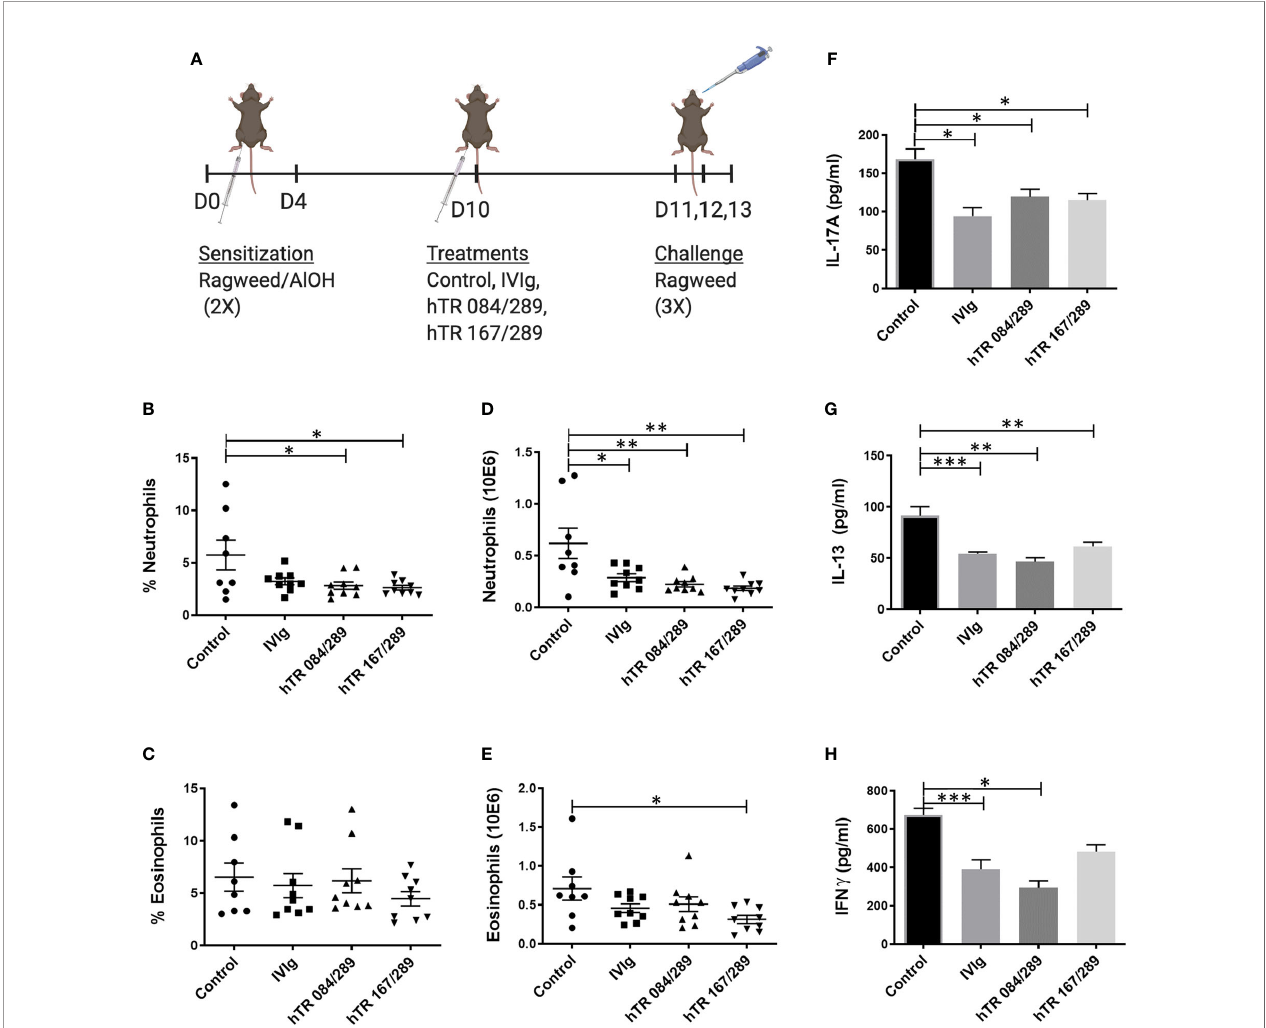
FIGURE 3 | Tregitopes modulate lung granulocytes and cytokines pro fi le of mice with ragweed-driven murine allergic airways disease. In the more acute ragweed model of allergic airway diseases, Tregitopes (and IVIG) signi fi cantly reduce cellular in fi ltration (neutrophil as well as eosinophils) and broadly reduce cytokine levels in the lungs. (A) Timeline of the ragweed-driven model of murine allergic airways disease used in this experiment. Sensitization to OVA/AlOH was performed on days 0 and 4. Treatment with Control, IVIg or Tregitopes was administered on day 10 and challenge was done intranasally with ragweed on days 11,12 and 13. (B) Percentage and (D) absolute number of neutrophils. (C) Percentage and (E) absolute number of lung eosinophils in the lungs of ragweed-allergic mice undergoing treatment with Control, IVIg or Tregitopes on day 10 (representative of 3 independent experiments, n = 5-9). (F) Cytokines concentration of IL-17A, (G) IL-13 and (H) IFN g measured by ELISA in whole lung homogenates. (representative of 3 independent experiments, n = 5-9). ***p, 0.001, **p, 0.01, *p, 0.05, one-way ANOVA